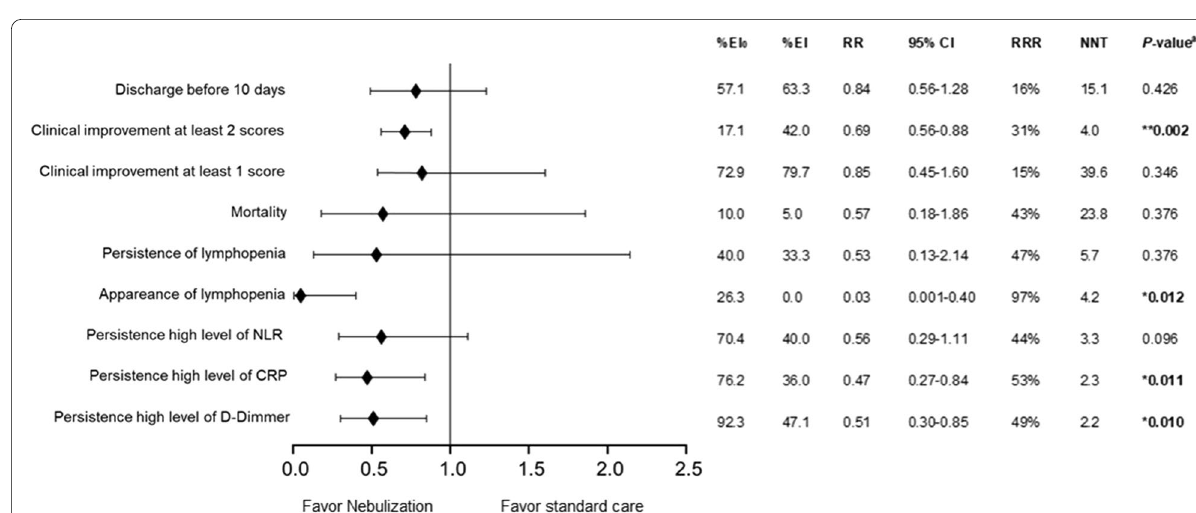
Fig. 5 Clinical impact on the assessed outcomes. Legend: NLR: Neutrophil to Lymphocyte Ratio; CRP: C‑Reactive Protein; EI 0 : Exposure Incidence in controls; EI: Exposure Incidence in peripheral blood non‑hematopoietic enriched stem cell cocktail treated‑patients; RR: relative risk; 95% CI: confidence interval; RRR: relative risk reduction; NNT: number needed to treat to produce the effect; a : Z‑test. *: significant; **: highly